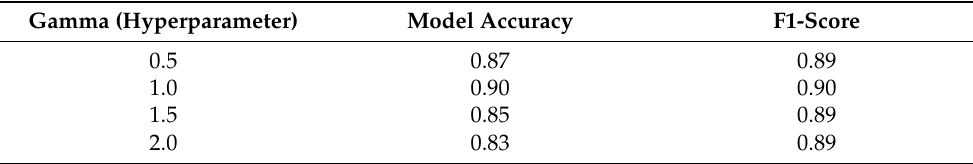
Table 4. Result of model performance using multiclass focal loss.